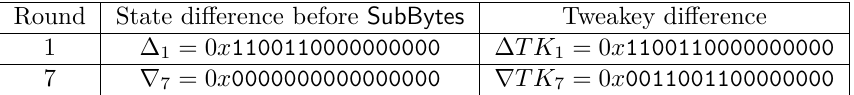
Table 11: Setting of the first six rounds of the boomerang distinguisher of TweAES Round